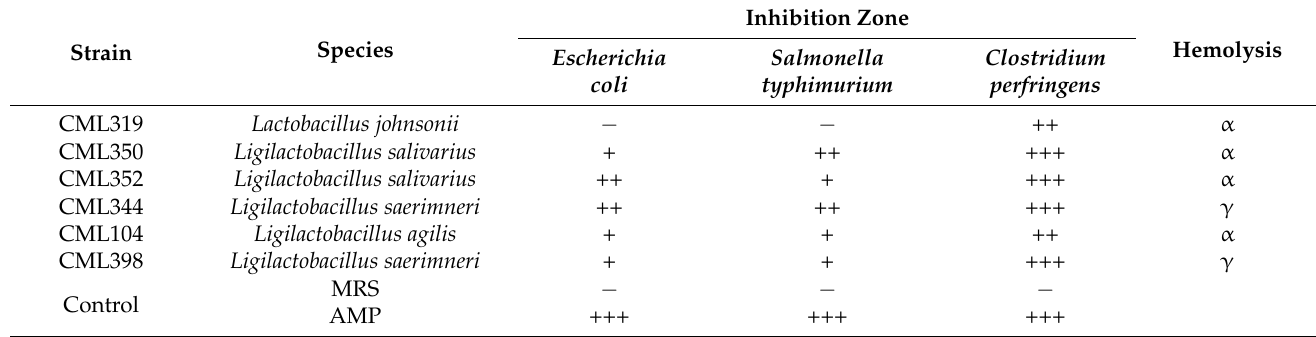
Table 7. Antimicrobial activity and hemolysis of selected lactic acid bacteria strains.